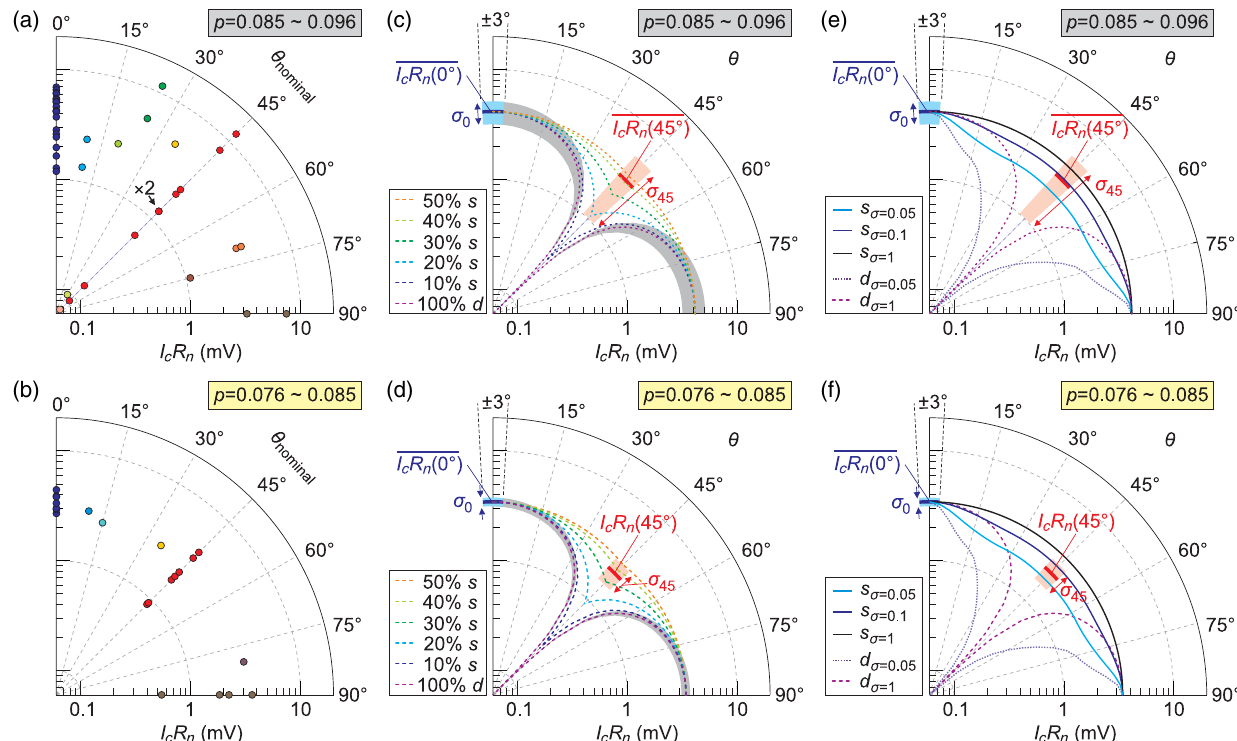
FIG. 10. (a),(b) Fan chart diagram of I c R n values as a function of the nominal twist angle for BSCCO junctions. The range of doping levels is indicated as shaded regions in Fig. 9. (c),(d) Comparison between I c R n values and the theoretically calculated angular dependence with s -wave or d -wave mixing. The error of (cid:2) 3 ° in twist angles is estimated from the TEM experiments. The dashed curves represent the theoretically expected angular dependence from purely d wave to 50% mixture of s wave (50% s ). The shaded gray region indicates the purely d -wave dependence by taking into account the data spread of σ 0 . (e),(f) Comparison between the experimentally obtained I c R n and the theoretically calculated angular dependence with different degrees of tunneling coherence (varied by the parameter σ , as explained in the Supplemental Material [45]). The theoretical curves are normalized by multiplying the calculated critical current J c ð θ Þ with a factor: I c R n ð 0 ° Þ =J c ð 0 ° Þ